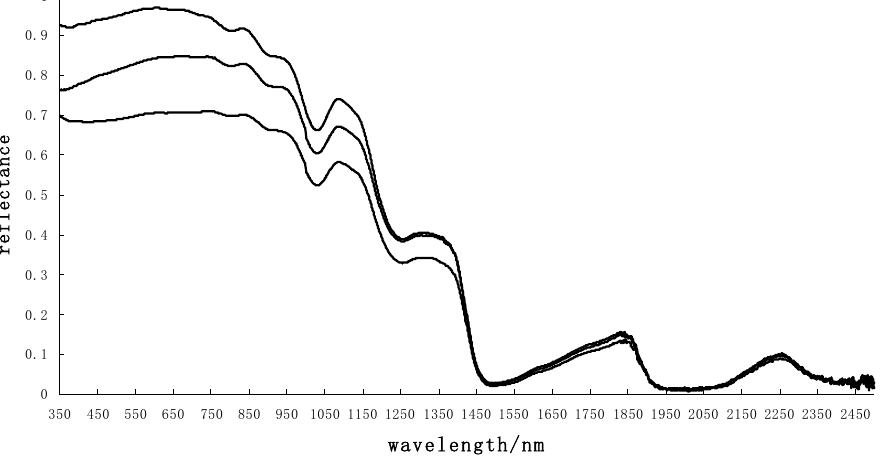
Figure 5. Snow spectral reflectance sampled in the Binggou